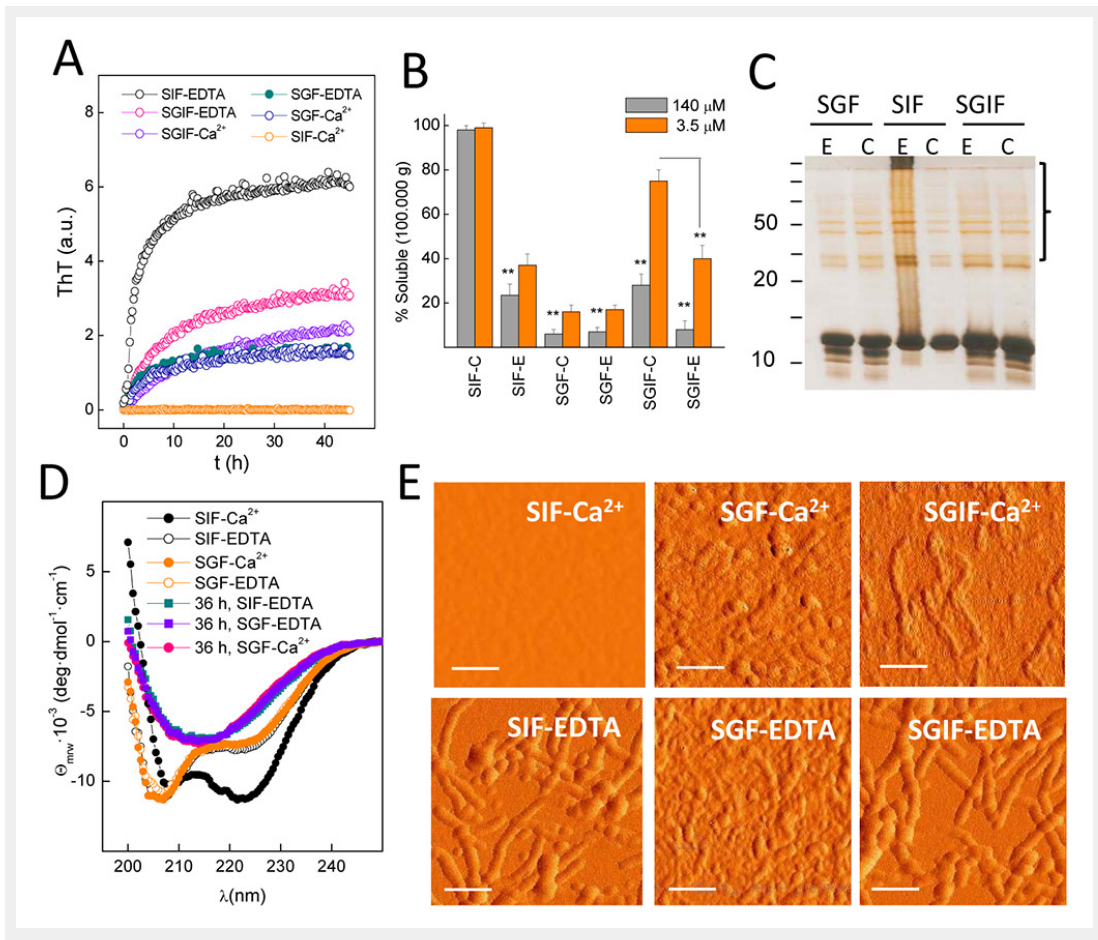
Figure 2 Amyloid-like aggregation of cod β-parvalbumin. ( A ) Kinetics of thioflavin T (ThT) binding indicate rGad m 1 fibril formation under simulated gastric fluid (SGF), simulated intestinal fluid (SIF) supplemented with 5 mM EDTA and simulated gastrointestinal fluid (SGIF) containing either 5 mM EDTA or 5 mM CaCl 2 . Reactions were performed at 37 °C using 140 μM rGad m1, and the measured fluorescence counts normalised. ( B ) Percentage of soluble rGad m 1 recovered in the supernatants of a 100,000 x g centrifugation after 36-h incubations in SIF, SGF and SIGF, supplemented with 5 mM EDTA (E) or 5 mM CaCl 2 . (C) show formation of insoluble aggregates under those conditions with increased ThT binding. Incubations were performed at 3.5 and 140 μM rGad m 1. Solubility percentages were determined by measuring the protein concentration in both the soluble and the pellet fraction using triplicates. Bar charts are presented as mean ±standard deviation (n = 3); ** p <0.05. ( C ) Analysis of rGad m 1 aggregates by use of sodium dodecyl sulfate polyacrylamide gel electrophoresis (SDS-PAGE) and silver staining shows bands at high molecular weight corresponding to SDS-resistant aggregates. ( D ) Circular dichroism (CD) spectra of 60 μM rGad m 1 in SGF and SIF supplemented with either 5 mM EDTA or 5 mM CaCl 2 indicate β-sheet structures after 36 h incubation of the apoforms. ( E ) Atomic force microscopy (AFM) images of rGad m1 incubated for 36 h under SGF, SIF and SGIF supplemented with 5 mM EDTA or 5 mM CaCl 2 indicating the formation of aggregates and of their fibrillar shape. Scale bars 100